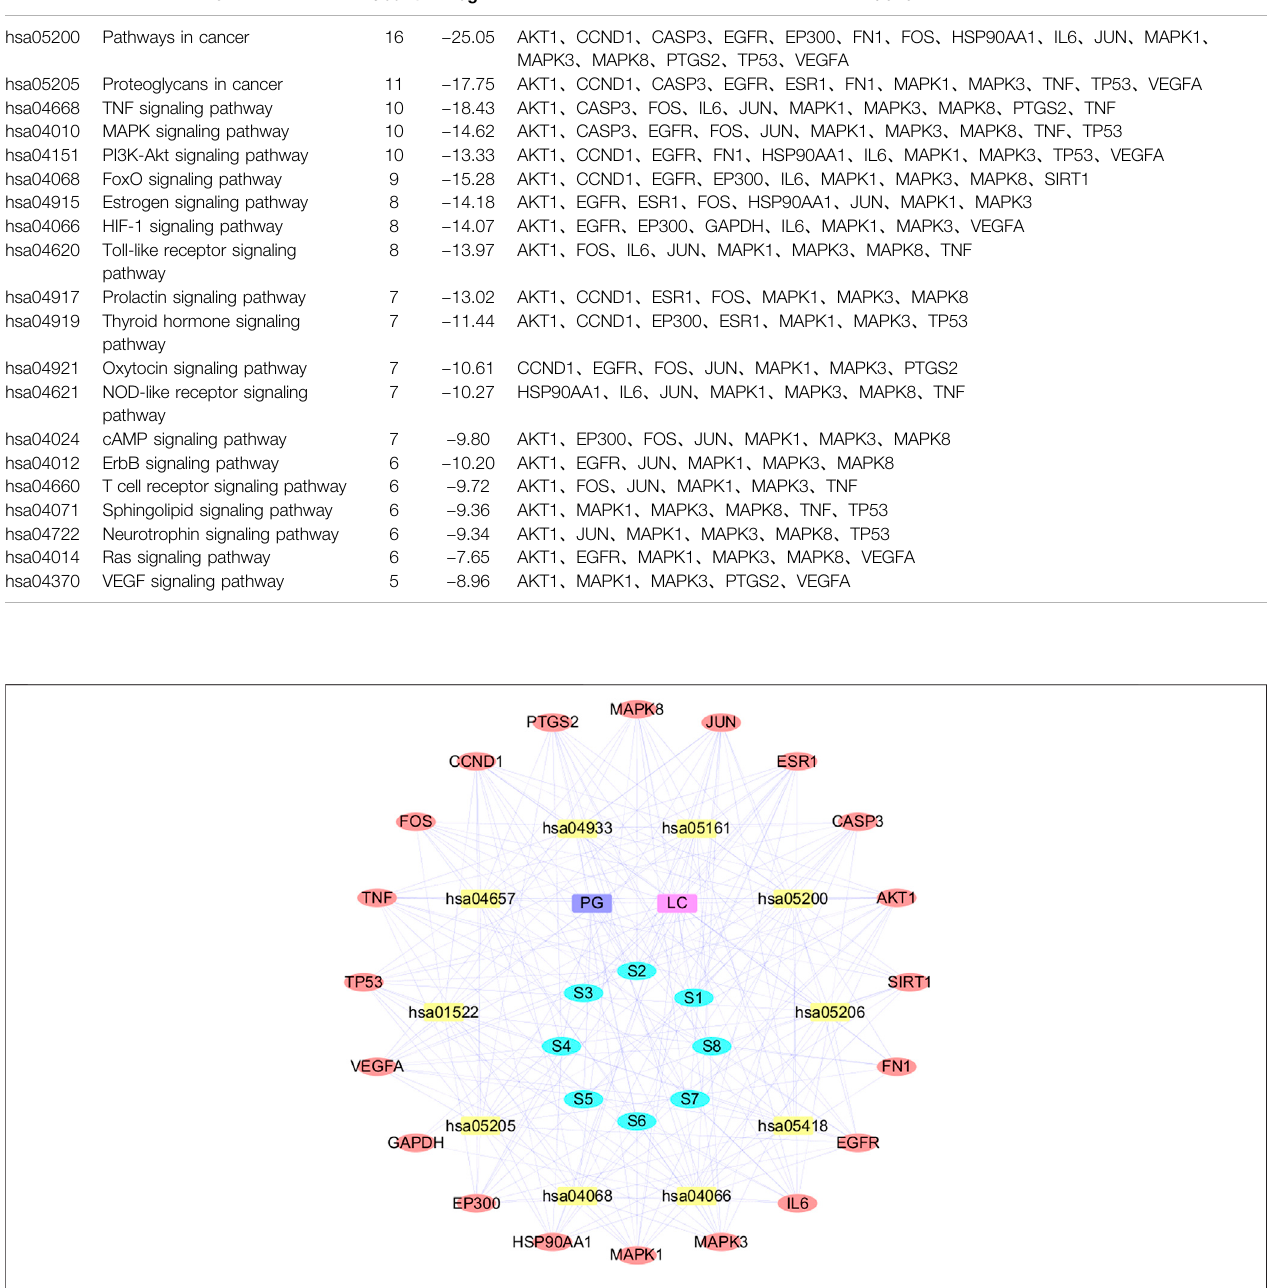
Frontiers in Pharmacology |